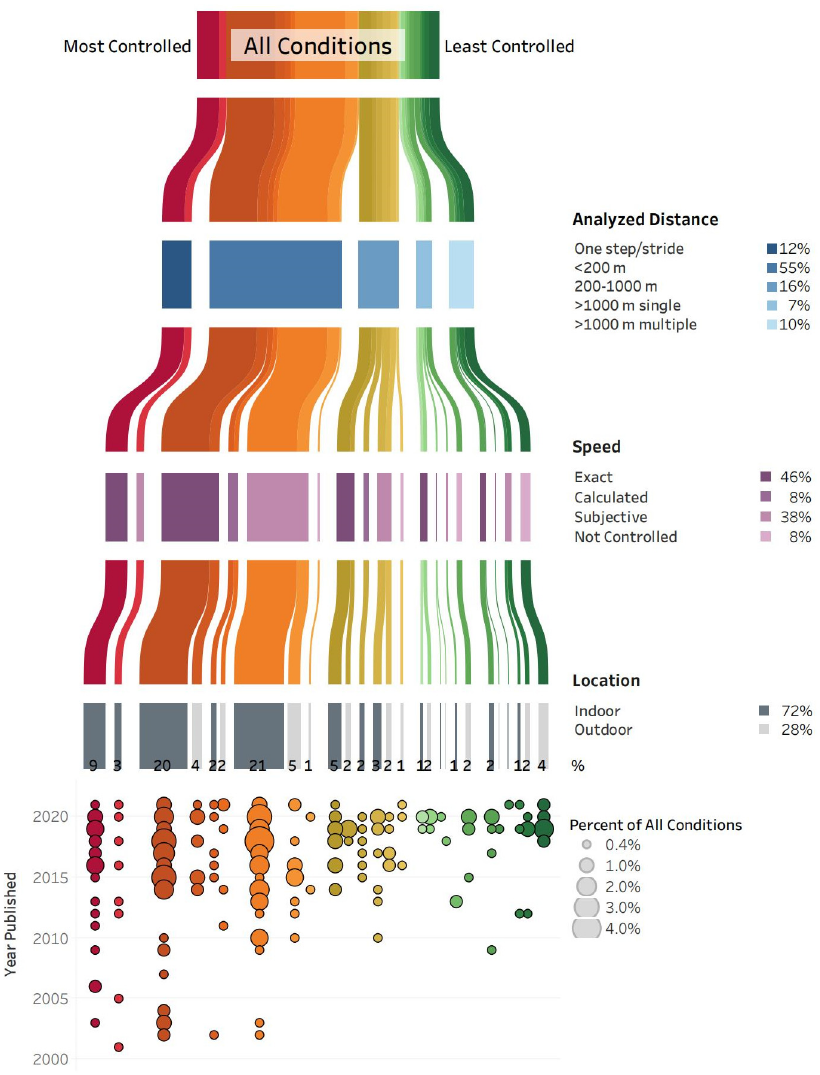
Figure 2. All conditions (262 across 231 studies) are grouped according to the analyzed distance, speed, and location. The condition groups are ranked from most controlled (red, on the left) to least controlled (green, on the right), and the width of each line corresponds to the percent of all conditions within that group. The degree of control is based on the analyzed distance (one step/stride is more controlled than >1000 m), speed (exact is more controlled than not controlled), and location (indoor is more controlled than outdoor). The percent of all conditions for each category of analyzed distance (shades of blue), speed (shades of purple), and location (shades of grey) is reported. In the bottom panel, the percent of all conditions within each group are further separated by year the study was published, with larger circles corresponding to a greater percent of all conditions. Note: 24 conditions that could not be categorized due to lack of information are not included in this figure.